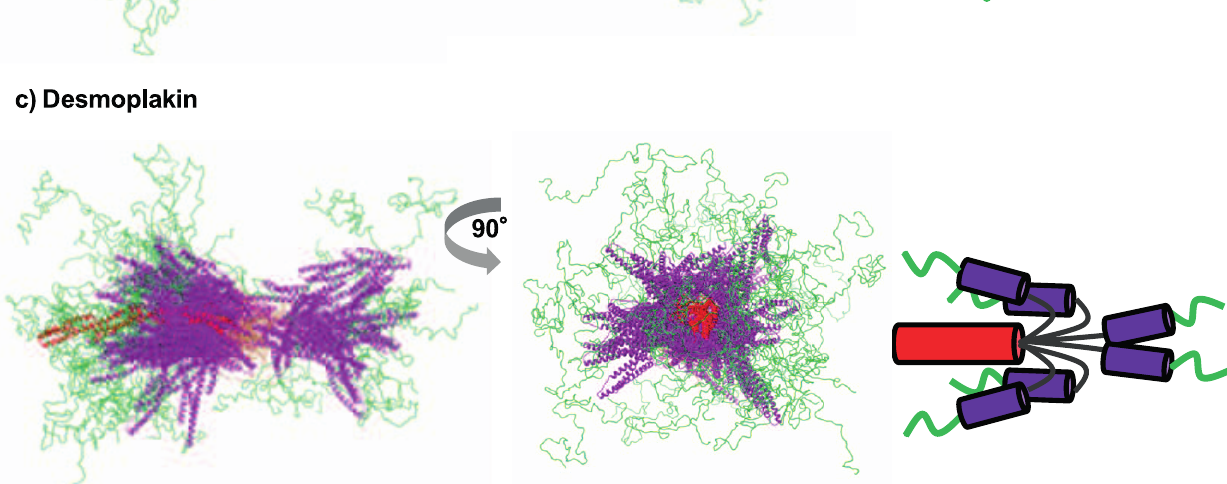
Figure 6. Molecular representations of the three plakin domains based on EOM selected conformers. The selected ensembles of only the 50 best structures which were selected by GAJOE are shown in two orthogonal views for (a) envoplakin, (b) periplakin and (c) desmoplakin. Also indicated are cartoon representations of the predominant conformers. The SR3-6 rods (red) were aligned and the SR7-8 rods (purple) and the CT region (green) allowed to rotate freely about the hinge (gold). C-terminal residues of SR8 are coloured red. Also indicated are cartoon representations of the predominant conformers.